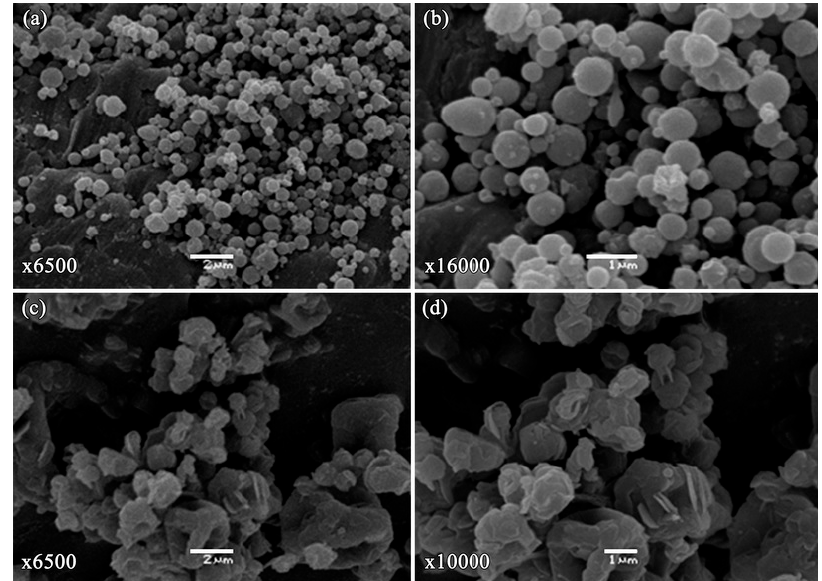
Figure 2. Scanning electron microscopy (SEM) images of dry powders: ( a , b ) 5FU-NS, obtained at 6500× and 16,000× magnifications, respectively; ( c , d ) 5FU-MS formulation, obtained at 6500× and 10,000× magnifications, respectively. Scale bars represent 2 µm (right) and 1 µm (left).